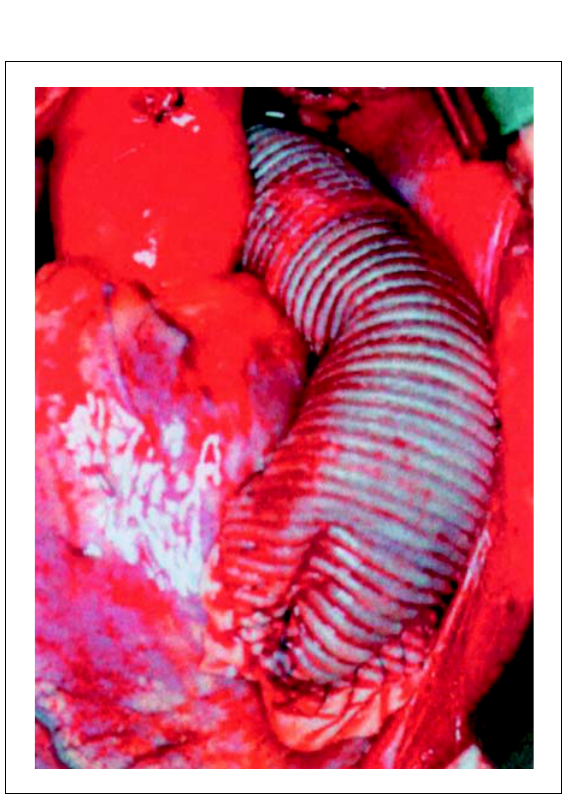
Fig. 5 – Conexão entre o ventrículo direito e artérias pulmonares com tubo valvado de pericárdio bovino corrugado.